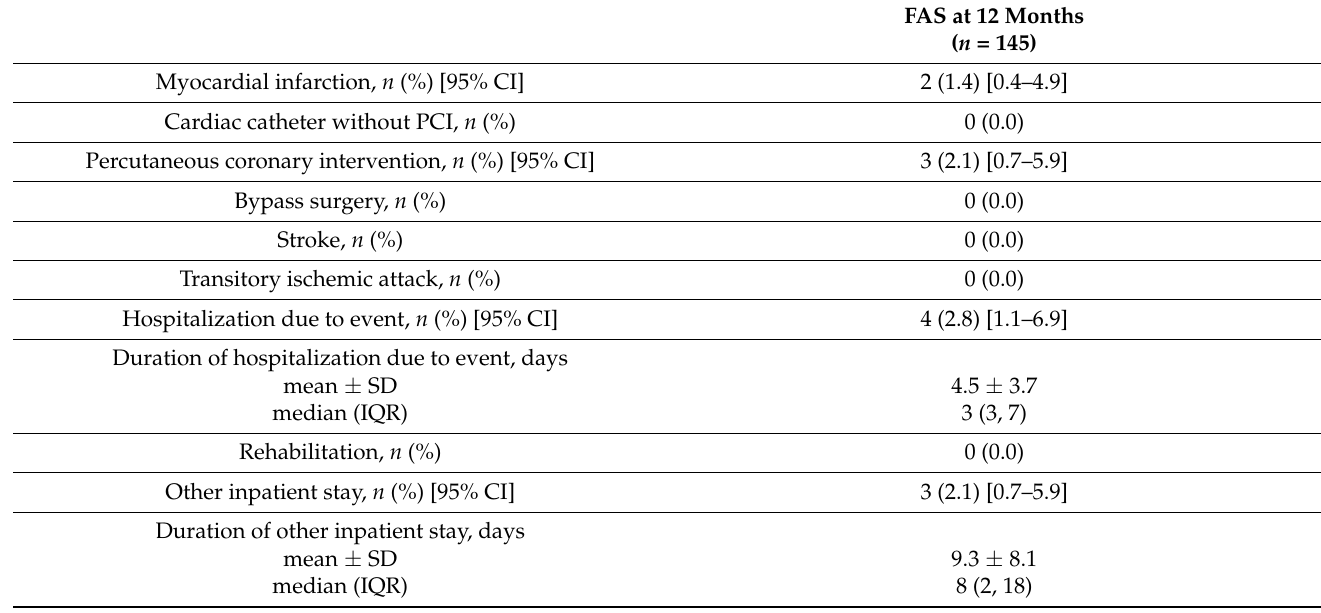
Table 5. Non-fatal outcomes at 12 months in the